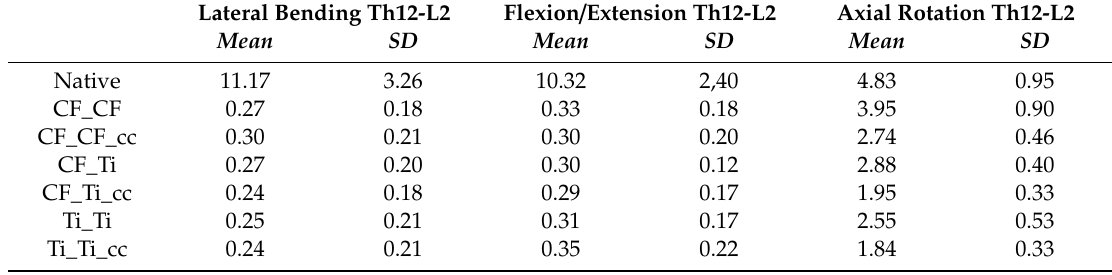
Table 1. Results of the range of motion (ROM) test.